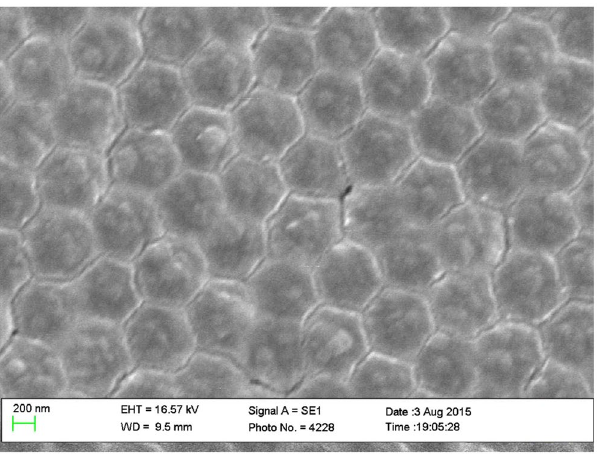
Figure 3. Plan view SEM image of the spherical Z_NS before complete removal of PS nanospheres i.e. samples were simply heated at 350 °C for 30 minutes to decompose the zinc acetate into zinc